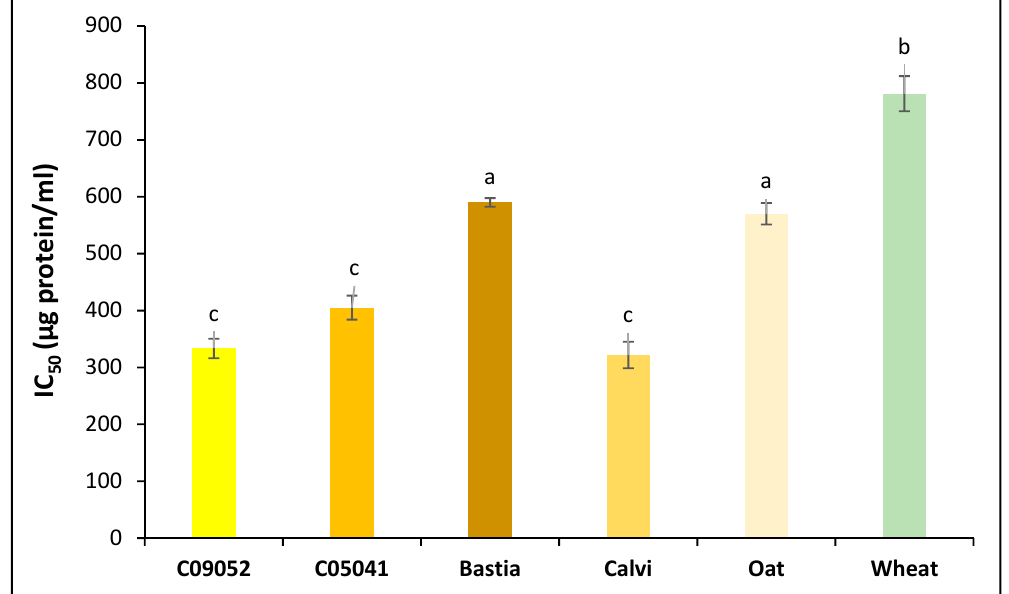
Figure 4. Antihypertensive activity (based on ACE inhibition) of canary seed, oat and wheat permeates prepared following flours in vitro gastrointestinal digestion and 3-kDa MWCO ultrafiltration. IC 50 : inhibitor concentration that inhibits enzyme activity by 50%. Di ff erent letters represent statistical di ff erence according to the LSD method by multiple range test ( α = 0.05) with a confidence level of 95%. Values represent mean ± SD (n = 3).